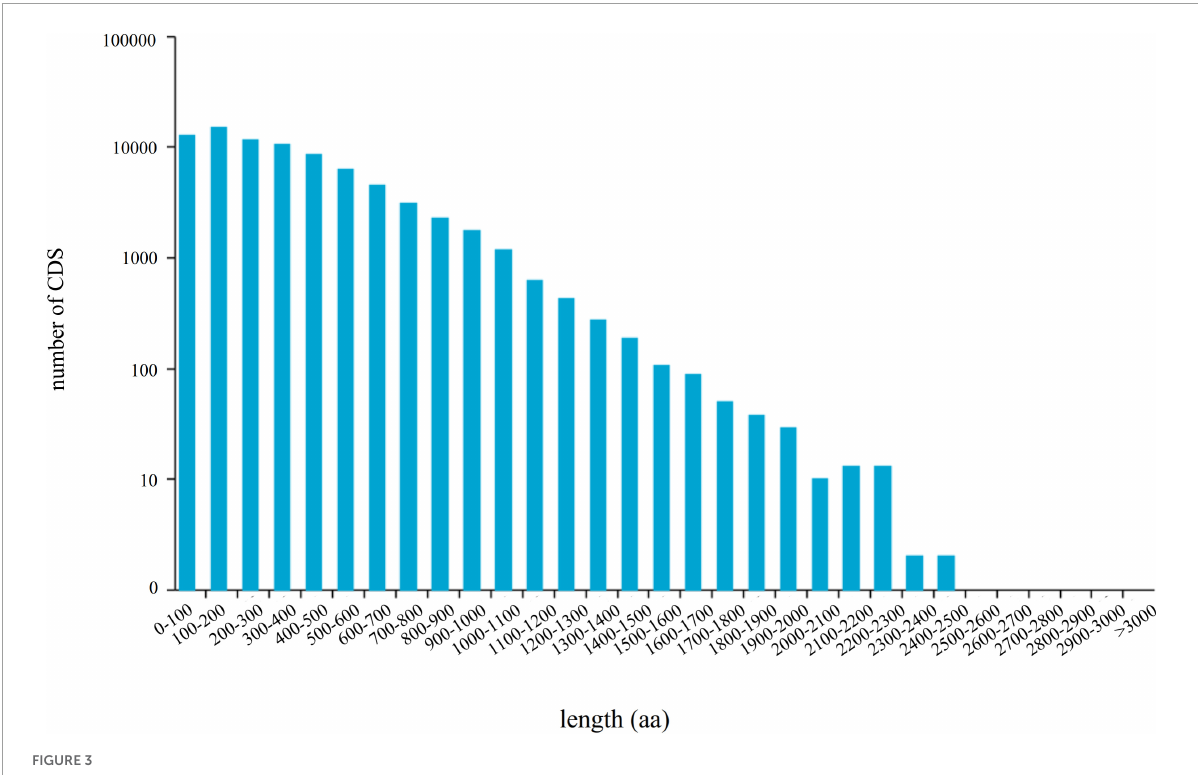
FIGURE3 The length distribution of 79,159 CDS-encoded protein sequences.